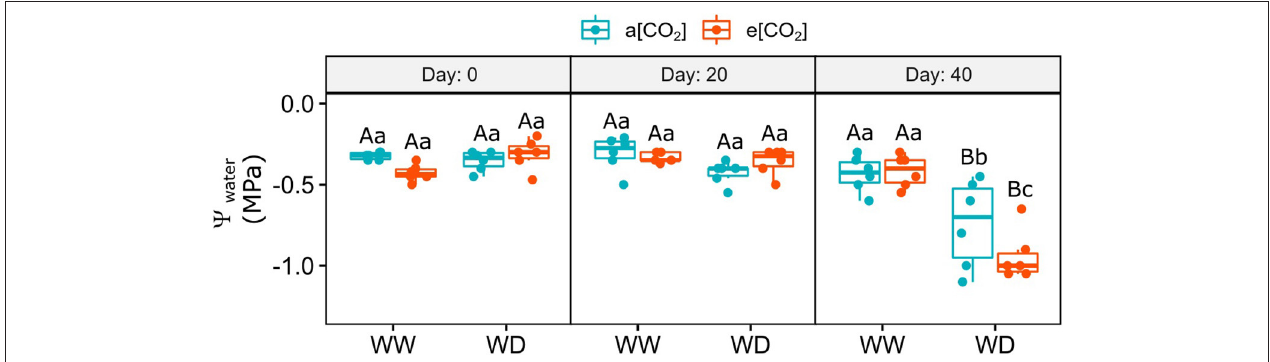
FIGURE 1 | Leaf water potential of C. arabica plants exposed to ambient [CO 2 ] under well-watered and water deficit (a[CO 2 ] + WW and a[CO 2 ] + WD, respectively) and elevated [CO 2 ] under well-watered and water deficit (e[CO 2 ] + WW and e[CO 2 ] + WD, respectively) conditions on day 0, 20, and 40 after water deficit imposition in the OTC. Boxes represent the median and first and third quartiles, symbols represent individual samples ( n = 6–5 biological replicates). Different capital letters represent significant differences between sampling day in the same water and [CO 2 ] condition, whereas different lowercase letters represent significant differences between water and [CO 2 ] conditions in the same sampling day according to Tukey’s test at 5% of probability ( P ≤